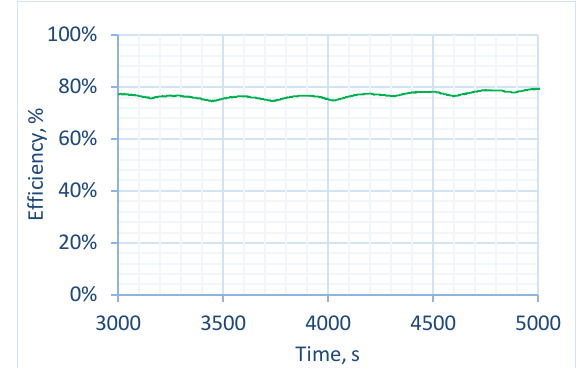
Fig. 6. The temperature efficiency over time.